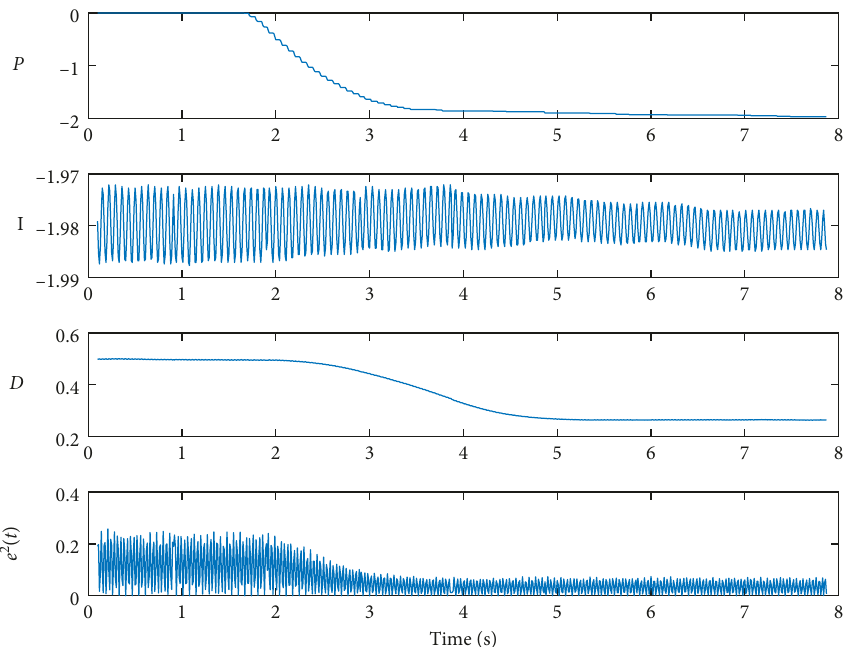
Figure 7: Self-tuning process of PID